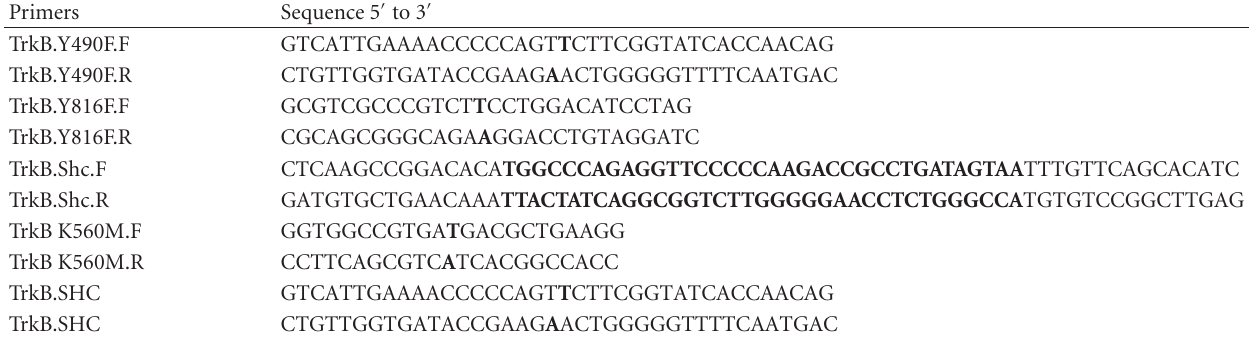
Figure 2: AICD-mediated Luciferase activity in SH-SY5Y-APP-Gal4 cells with TrkB knockdown or TrkB overexpression. (a) shRNA- mediated NTRK2 knock-down. Luciferase activity is decreased by NTRK2 knockdown compared to nonsilencing control ( P = . 03). There is no significant di ff erence between luciferase activity in NTRK2 knockdown and APP knockdown cells. shRNA constructs: negative control, NS, scrambled shRNA sequence; positive control, APP, shRNA targeting APP; experimental shRNA, NTRK2.1-3, shRNA constructs targeting all TrkB isoforms. The experiment was repeated four times independently and each time with six replicates. (b) TrkB isoform overexpression. Luciferase activity was not altered by TrkB T compared to GFP control. Luciferase activity was increased by TrkB FL ( P = . 01) and decreased by TrkB SHC ( P = . 01) compared to a GFP-control vector. The experiment was repeated 3 to 6 times independently with 6 replicates each time. The y -axis represents the arbitrary light units of firefly luciferase normalized to cell number (a) or transfection e ffi ciency (b). Error bars = SEM. Statistical analysis: ANOVA and Students t -test with Bonferroni correction where applicable. Table 1: Primer sequences used to obtain the point mutations and the sequence insertion on the TrkB FL receptor. The mutated bases are represented in